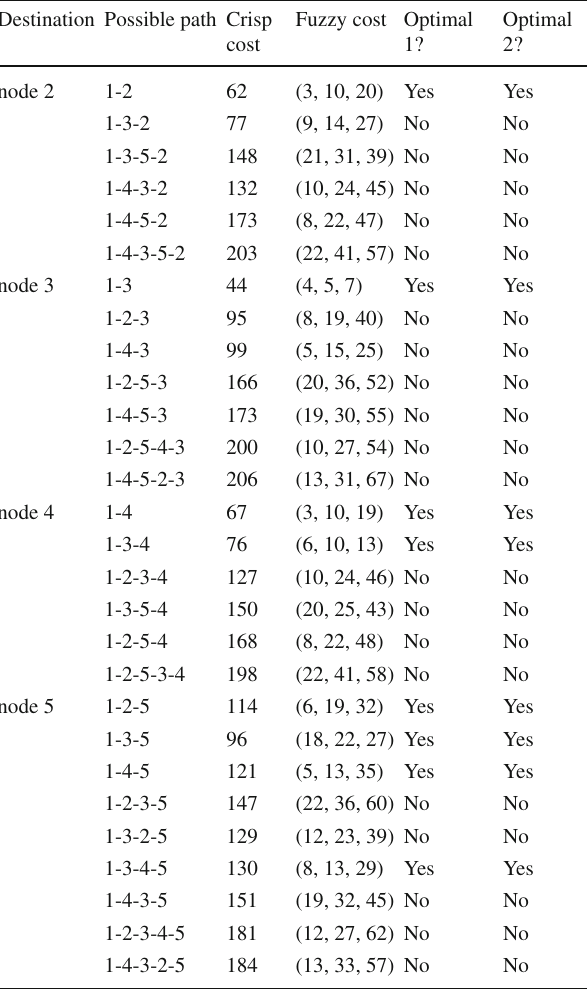
ple 1. Table 4 lists all possible paths to each node and their corresponding values. Optimal 1 and Optimal 2 in Table